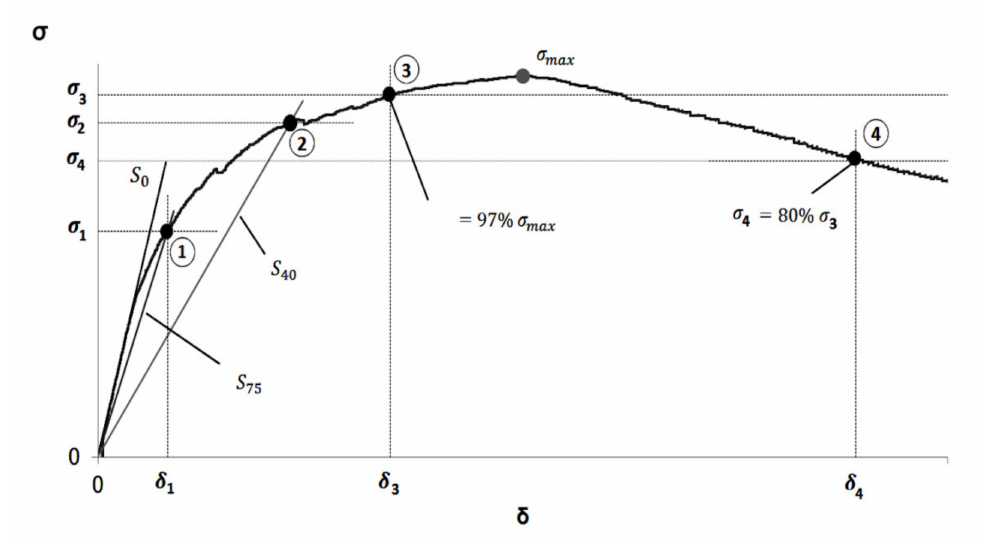
Figure 9. Stress–strain curves and key